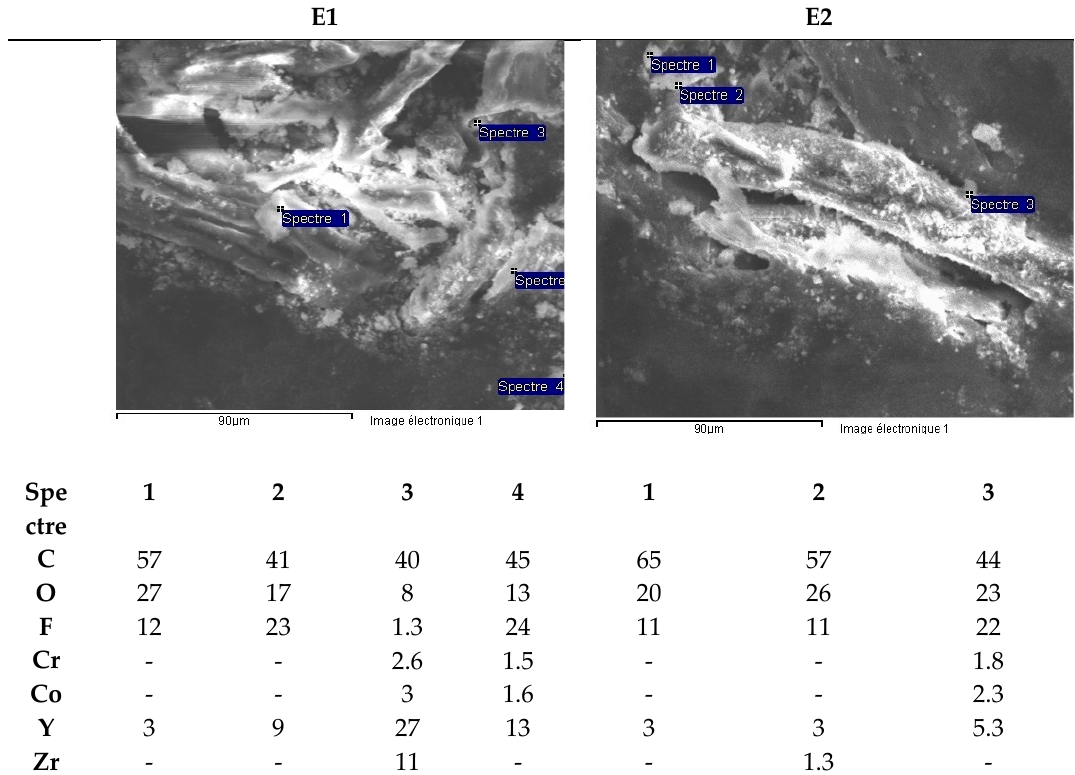
Figure 20. Black zirconia ceramic bracelet components (E1 and E2). SEM analysis of microfibers from filter paper.